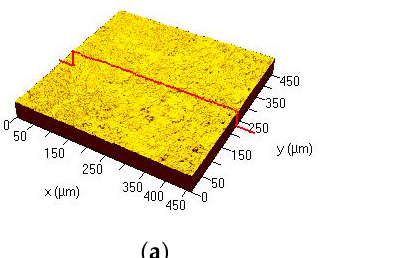
Figure 2. 3D images of the surface microstructures with dimensional range of 50 µm as captured by confocal laser scanning microscopy (CLSM). ( a ) Control group = Ti disk; ( b ) Test group = zirconia disk.